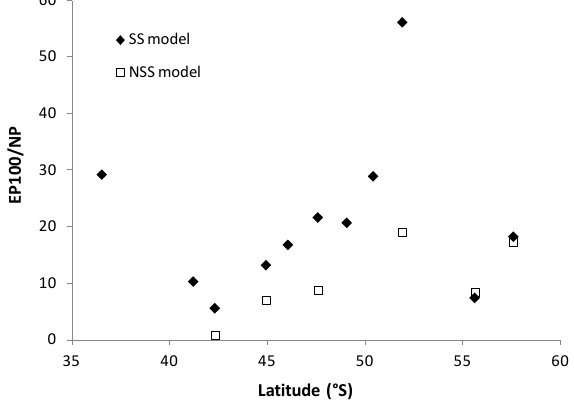
Fig. 8. Latitudinal variation of SS and NSS POC export flux at 100m as a % of new production (NP; Joubert et al.,